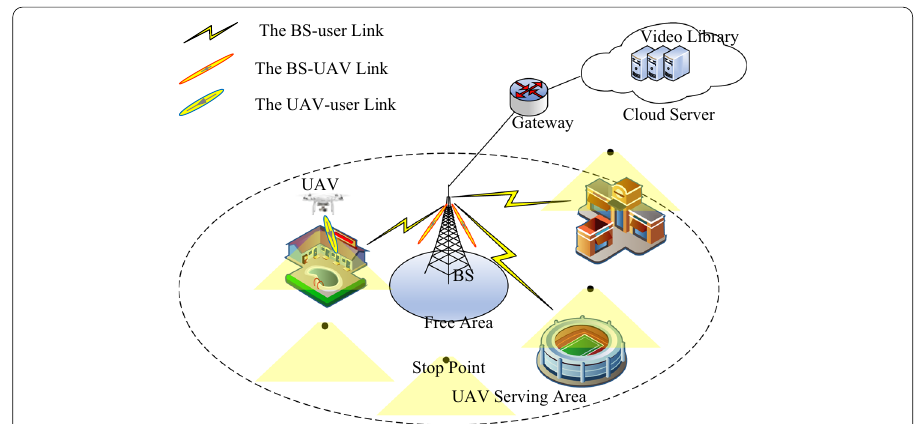
Fig. 1 The proposed network